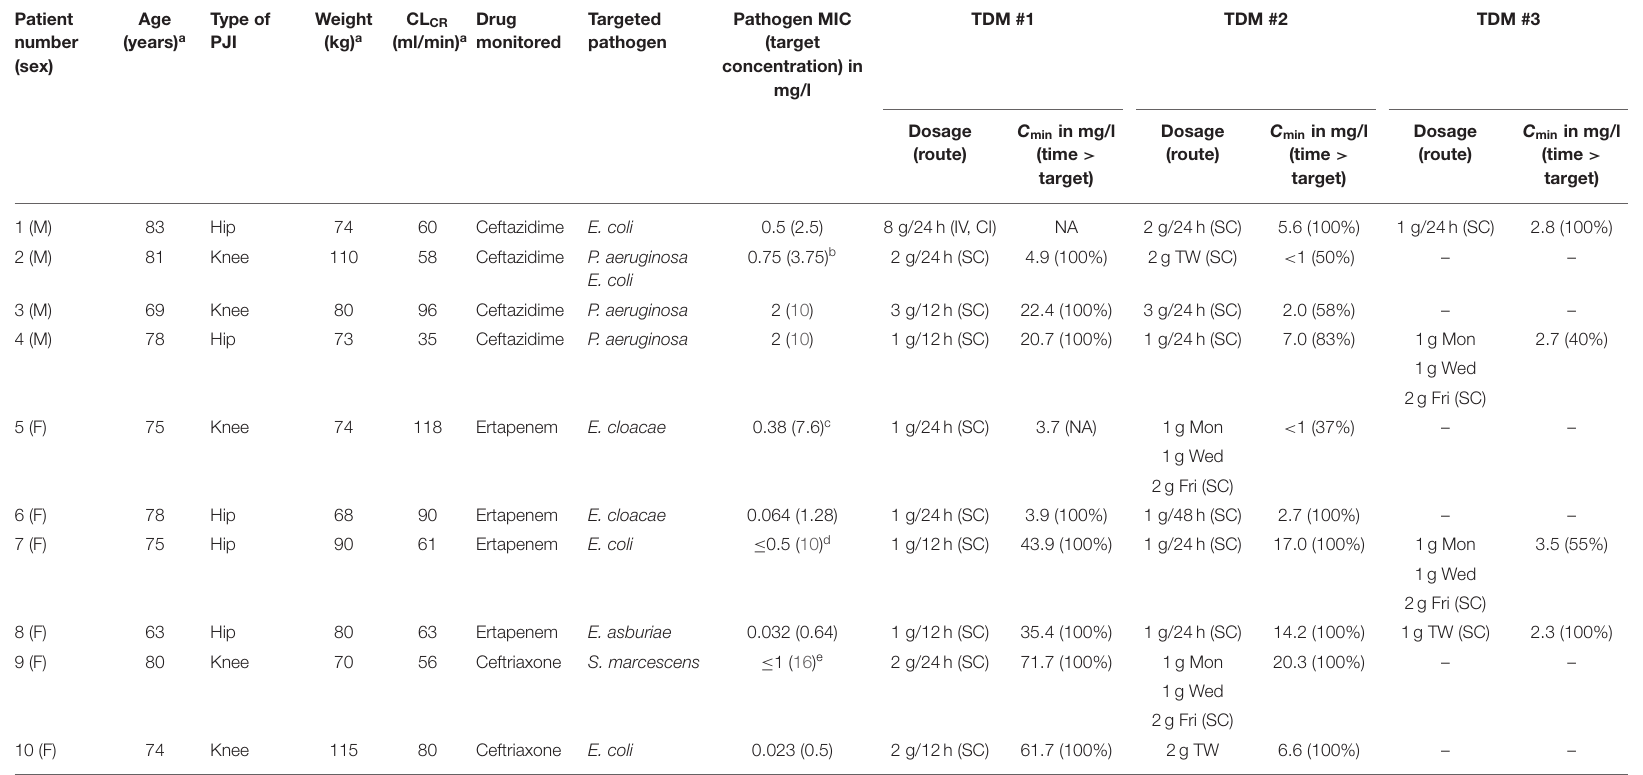
TABLE 1 | Characteristics of patients who received SC outpatient beta-lactam therapy and model-based TDM results. Patient